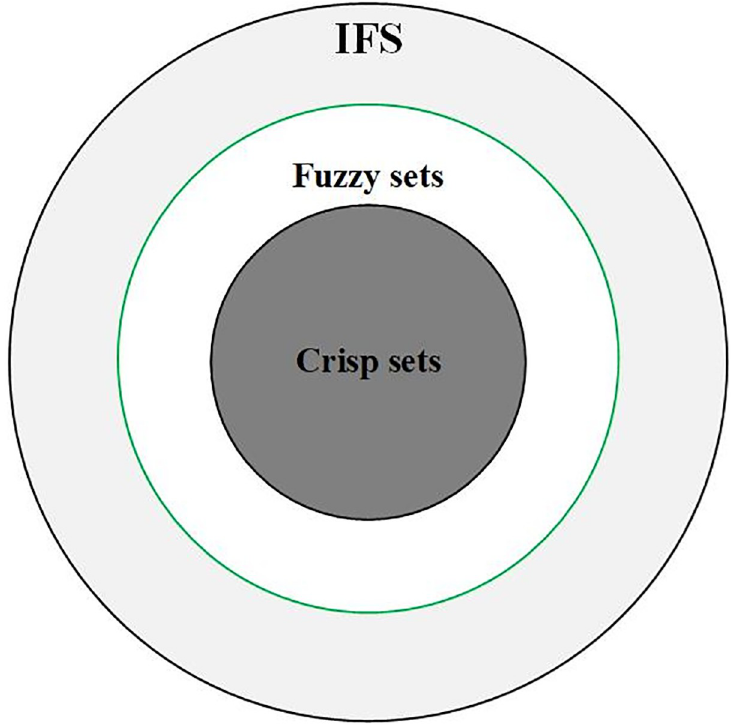
Fig 2. Relationships between crisp, fuzzy, and intuitive fuzzy